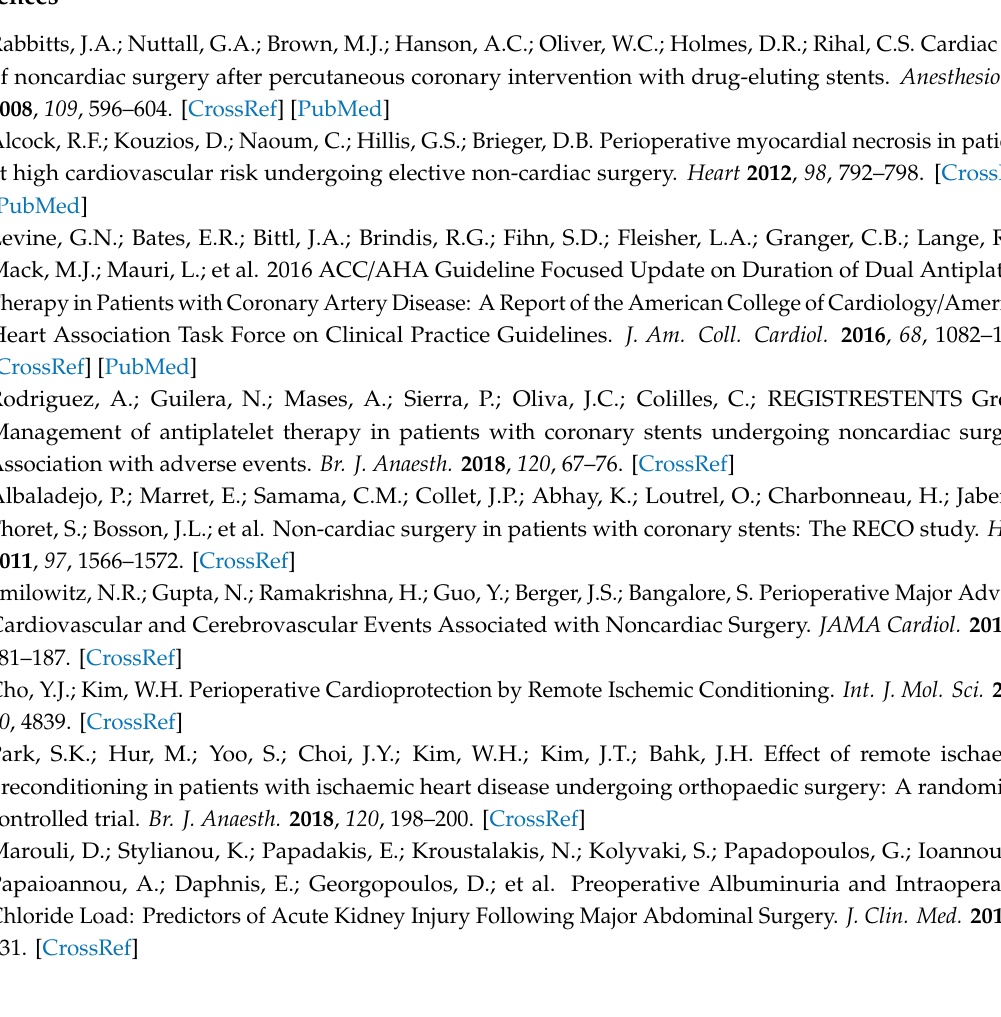
Figure S1. Histogram and covariate balance plot of distribution of propensity scores between patients with total intravenous anesthesia and sevoflurane; Figure S2. Histogram and covariate balance plot of distribution of propensity scores between patients with total intravenous anesthesia and desflurane; Figure S3. Histogram and covariate balance plot of distribution of propensity scores between patients with sevoflurane and desflurane; Table S1. Comparisons of major adverse cardiovascular and cerebral event and major bleeding between patients with total intravenous anesthesia and sevoflurane before and after propensity score matching; Table S2. Comparisons of major adverse cardiovascular and cerebral event and major bleeding between patients with total intravenous anesthesia and desflurane before and after propensity score matching; Table S3. Comparisons of major adverse cardiovascular and cerebral event and major bleeding between patients with sevoflurane and desflurane before and after propensity score